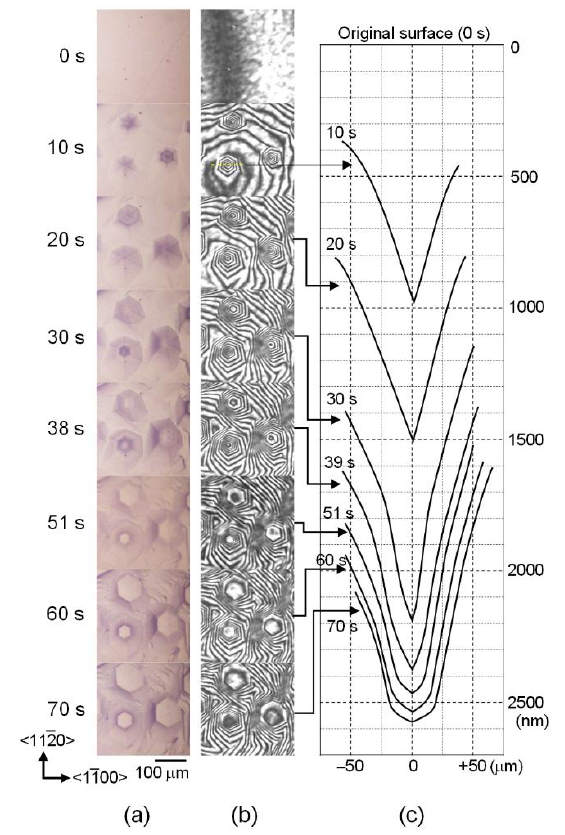
Figure 2. Time evolution of dissolution pit on C face of 4H-SiC: ( a ) bright-field images of 300 × 300 μ m 2 , ( b ) interference images for the same area in ( a ), and ( c ) calculated vertical trace of the interface along the < 1100 > direction at a dissolution pit located at the left-bottom part of the images.